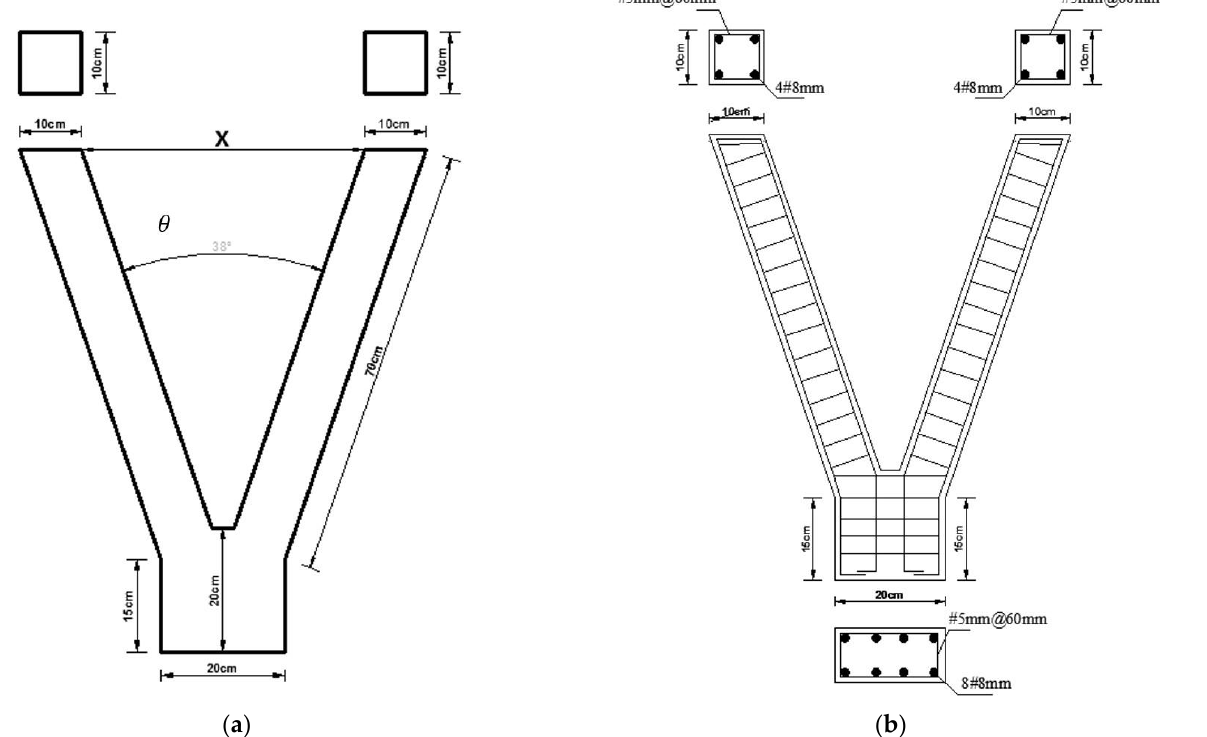
Figure 1. ( a ) Configurations of V-shaped column and ( b ) reinforcement details. Table 1. Specimen details.